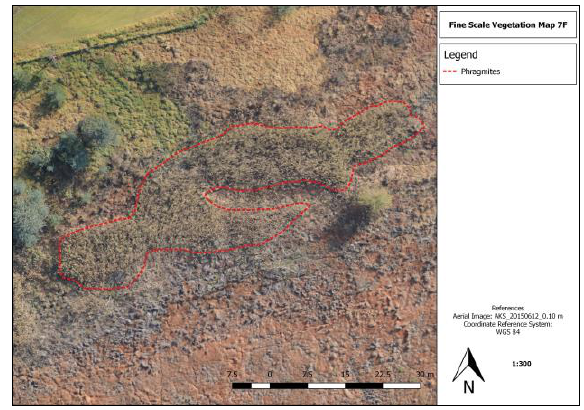
Figure 4. Extent of small pockets of untransformed hydrophilic